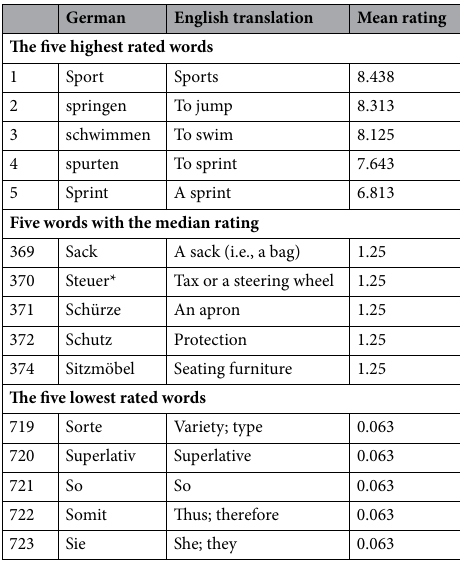
Table 5. Words with highest, median or lowest ratings. Generated words with the five highest and lowest mean ratings and five words with the median rating in the own body movement dimension. *This German word has two